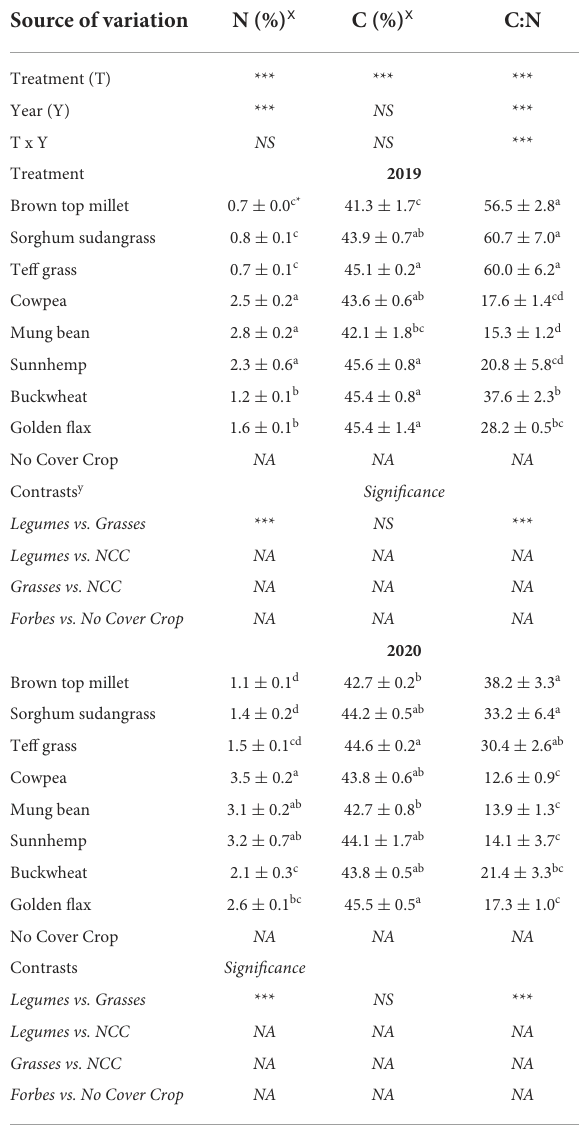
TABLE 5 Mean percent nitrogen (N) and carbon (C) and C:N ratio of dried cover crops collected following cover crop termination in Ames, IA.